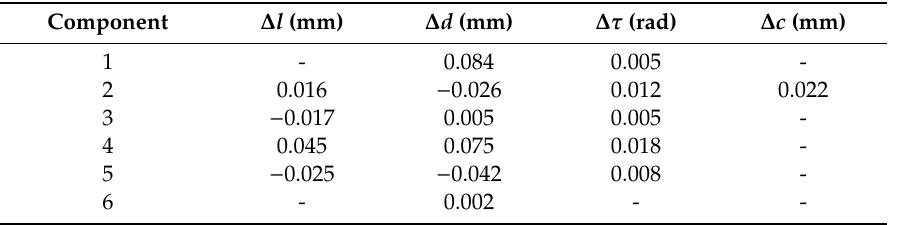
Table 3. Inspection values of the